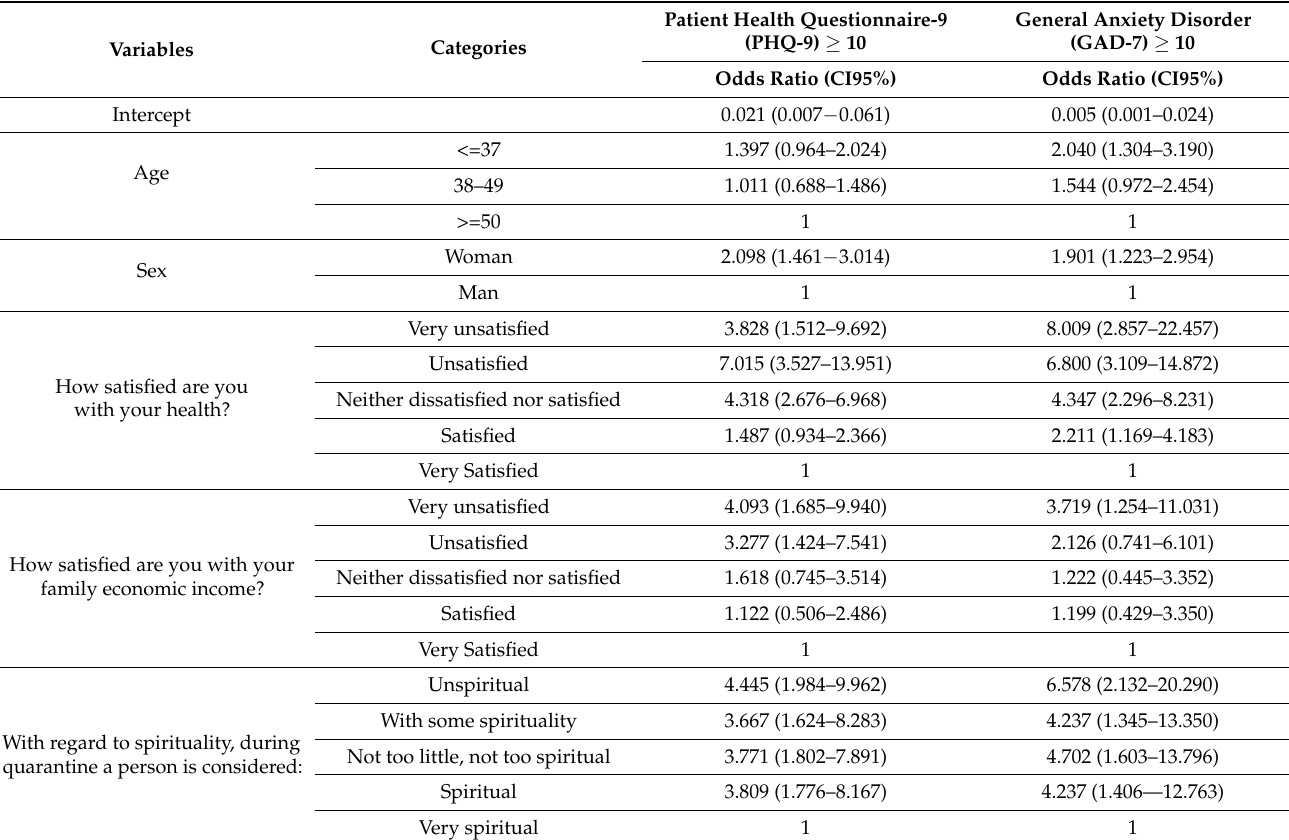
Table 4. Logistic regression analysis of depressive and anxiety symptoms and their